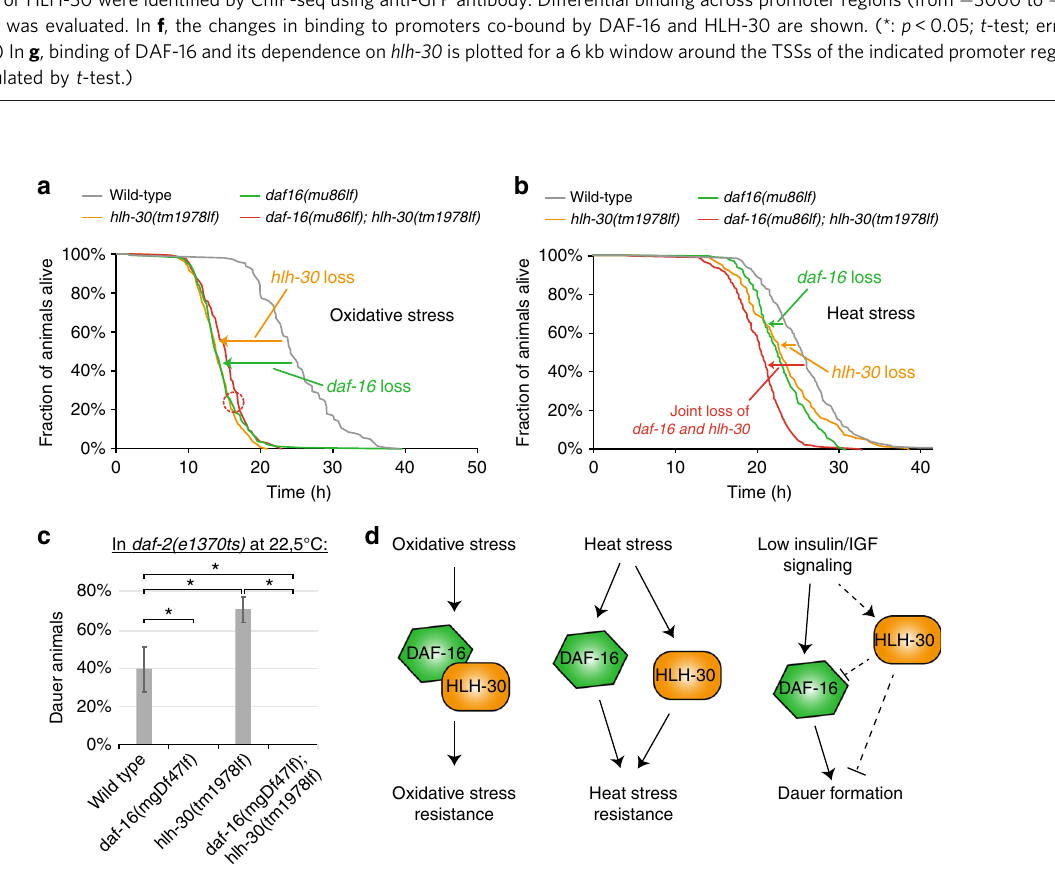
Fig. 5 DAF-16/FOXO and HLH-30/TFEB co-occupy many target promoters. a – e daf-2(e1370ts) animals expressing DAF-16::GFP or HLH-30::GFP were grown asynchronously at 15 °C, then shifted for 20 h to 25 °C, until the animals were harvested. Sites bound by DAF-16 and HLH-30 were identi fi ed by ChIP-seq using anti-GFP antibody. a DAF-16 and HLH-30 bound sites are enriched in the fi rst 500 bp upstream of transcriptional start sites (TSSs). Looking at all genes in the genome ( n = 20,389), enrichment of DAF-16 and HLH-30 in a 6 kb window around their transcriptional start sites (TSSs) is shown. b Genes within 2.5 kb downstream of DAF-16 bound sites are enriched for genes transcriptionally activated but not for genes repressed by DAF-16. Similarly, genes within 2.5 kb downstream of HLH-30 bound sites are enriched for genes transcriptionally activated but not for genes repressed by HLH-30. The gene expression information used here was taken from Fig. 4. Signi fi cant enrichments are indicated (**: p < 10 − 8 , *: p < 0.01; hypergeometric test). c Venn diagram illustrating the numbers of identi fi ed DAF-16 and HLH-30 bound sites as well as their overlap. # : Sometimes a DAF-16 bound site overlapped with multiple HLH-30 bound sites. Thus, the overlap actually comprises 1172 DAF-16 bound sites overlapping with 1327 HLH-30 bound sites. (Signi fi cance of site overlap was determined by Fisher ’ s exact test.) d GO-term enrichment analysis of the closest genes within 2.5 kb downstream of sites co-bound by DAF-16 and HLH-30. Only GO-terms of signi fi cant enrichment are shown (DAVID score ≥ 1). Arrows and pink color highlight GO-terms related to aging. e Examples of DAF-16 and HLH-30 binding to different promoter regions in the UCSC genome browser. Black bars indicate binding sites called by MACS. f , g daf-2(e1370ts) or daf-2(e1370ts); hlh-30(tm1978lf) animals expressing DAF-16::GFP as well as daf-2(e1370ts) or daf-2(e1370ts); daf-16 (mu86lf) animals expressing HLH-30::GFP were grown asynchronously at 15 °C, then shifted for 20 h to 25 °C, until the animals were harvested. Sites bound by DAF-16 or HLH-30 were identi fi ed by ChIP-seq using anti-GFP antibody. Differential binding across promoter regions (from − 3000 to + 600 bp around the TSSs) was evaluated. In f , the changes in binding to promoters co-bound by DAF-16 and HLH-30 are shown. (*: p < 0.05; t -test; error bars indicate variance.) In g , binding of DAF-16 and its dependence on hlh-30 is plotted for a 6 kb window around the TSSs of the indicated promoter regions. ( p -